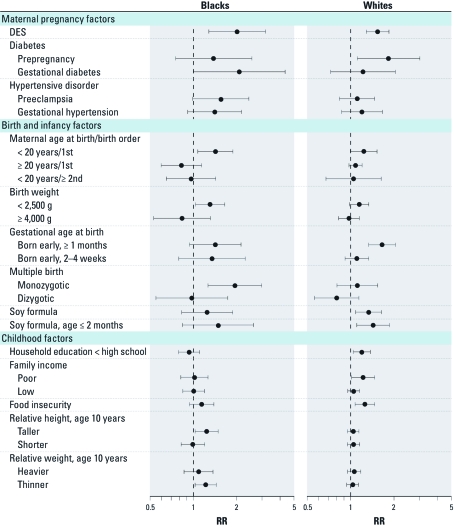
Comparisons in associations [RR (95% CI)] of selected early-life and childhood exposures with early-onset fibroids between black and white women, 35–59 years of age, in the Sister Study, 2003–2009.